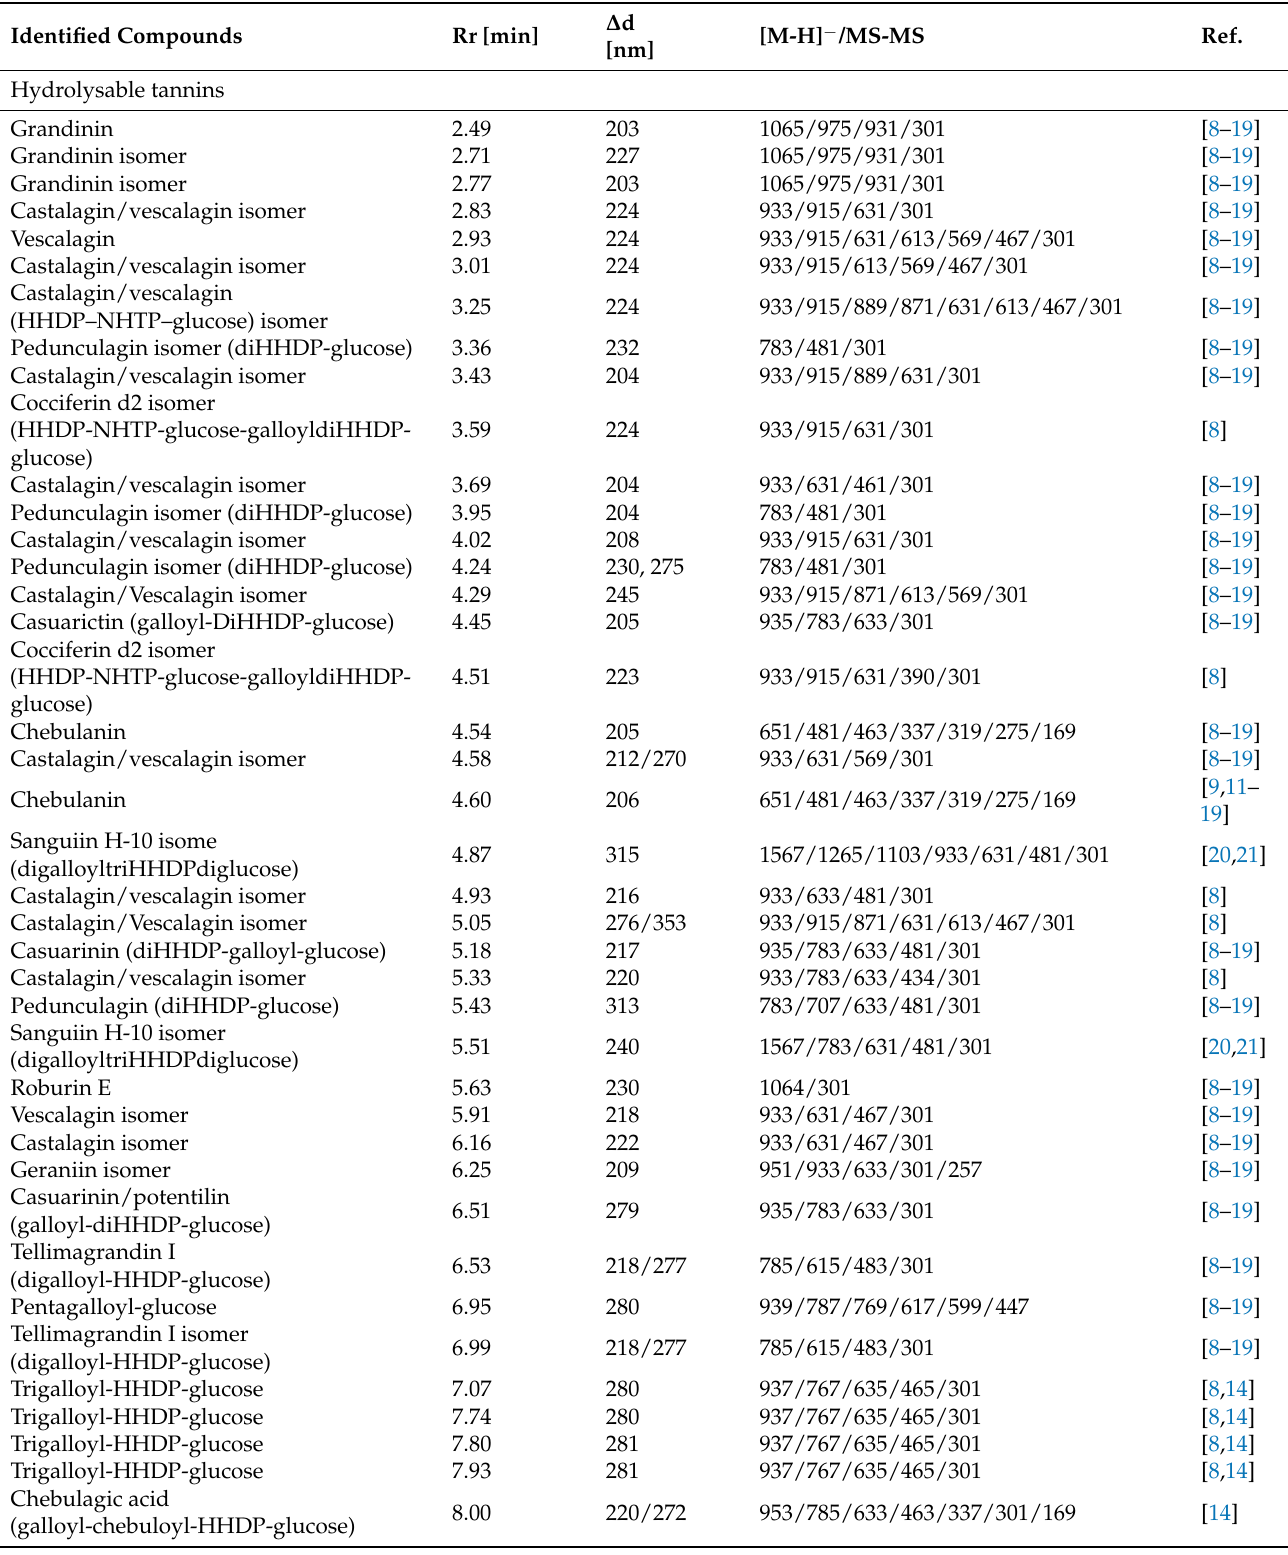
Table 1. Characterization of polyphenolic compounds in Stachys palustris L. by